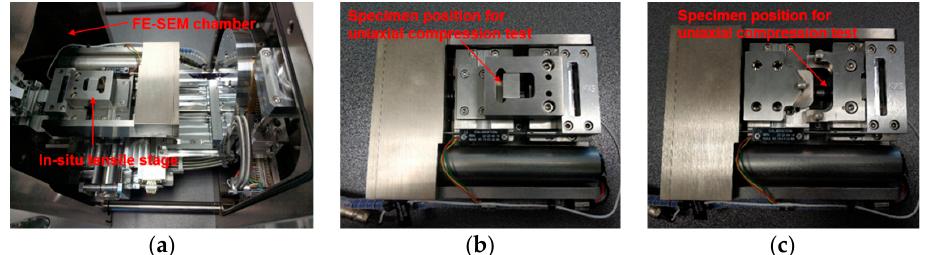
Figure 3. Experimental equipment: ( a ) In situ tensile stage loaded in the SEM chamber; ( b ) Specimen position in the compression clamp; ( c ) Specimen position in the three-point bending clamp.